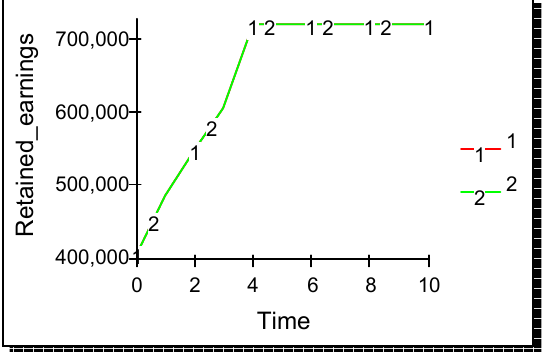
Figure 3. Bilateral demand tilting advertising σ 11 = σ 12 = σ 22 = σ 21 = 1.5 × 10 − 10 .